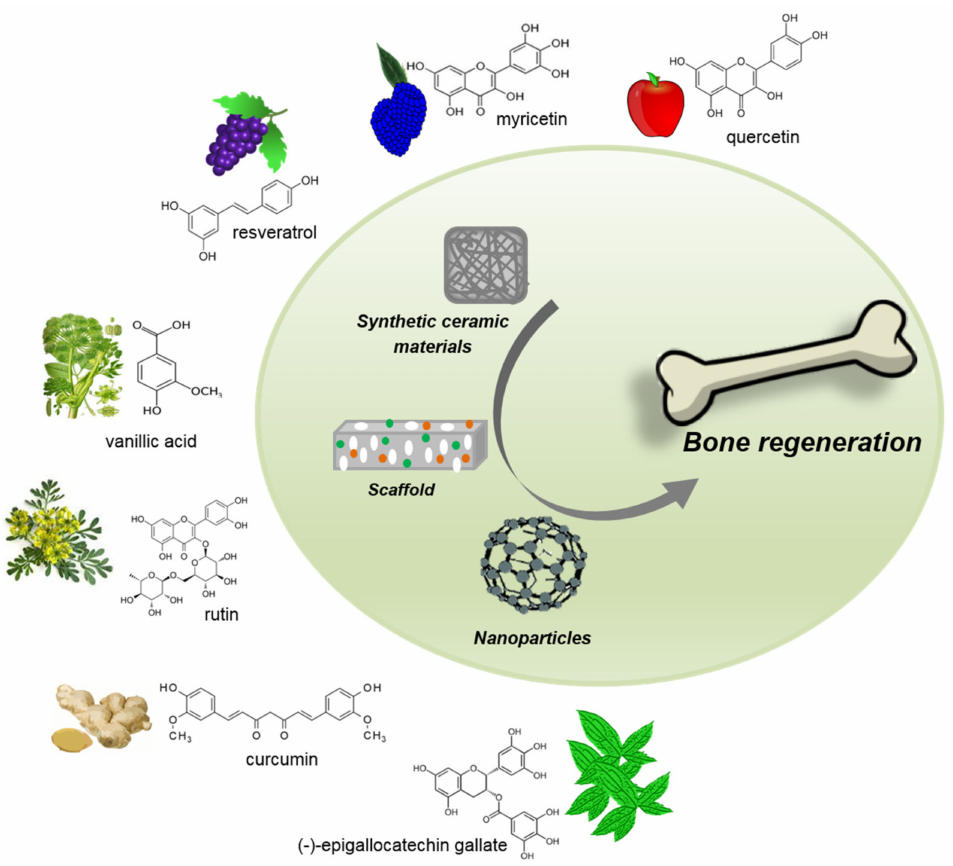
Figure 2. Schematic representation of the main phyto-bioactive nano delivery systems involved in bone